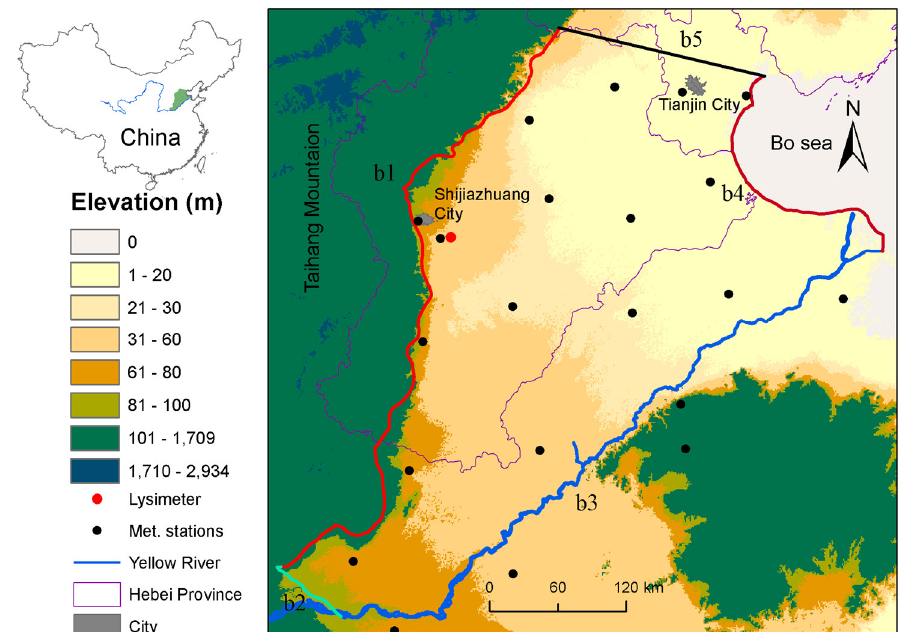
Figure 1. Location of study area. The boundary conditions of the hydrological model for the area are defined as follows: b1: specified gradient along Mt. Taihang ridge, b2: specified gradient at the south-western boundary, b3: specified hydraulic head along the Yellow river, b4: specified hydraulic head (0 m) along the coast line, b5: no-flow along a streamline toward north.